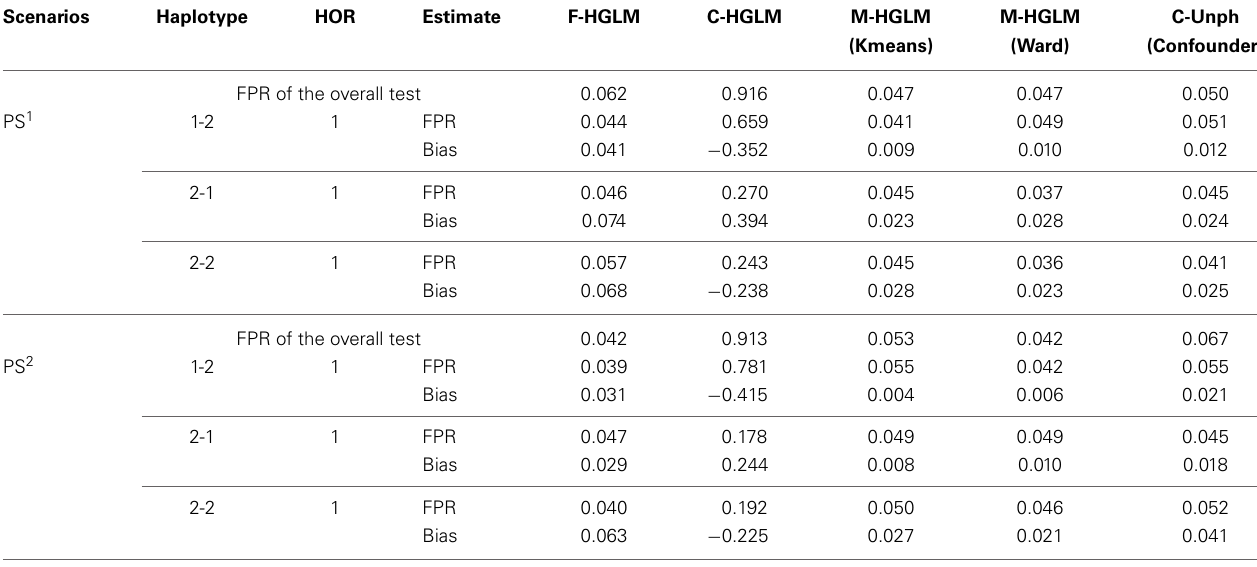
PS 1 : Population cases and controls are randomly ascertained from admixed population consisting of two strata with disease prevalence (7%, 18%) and HFs for